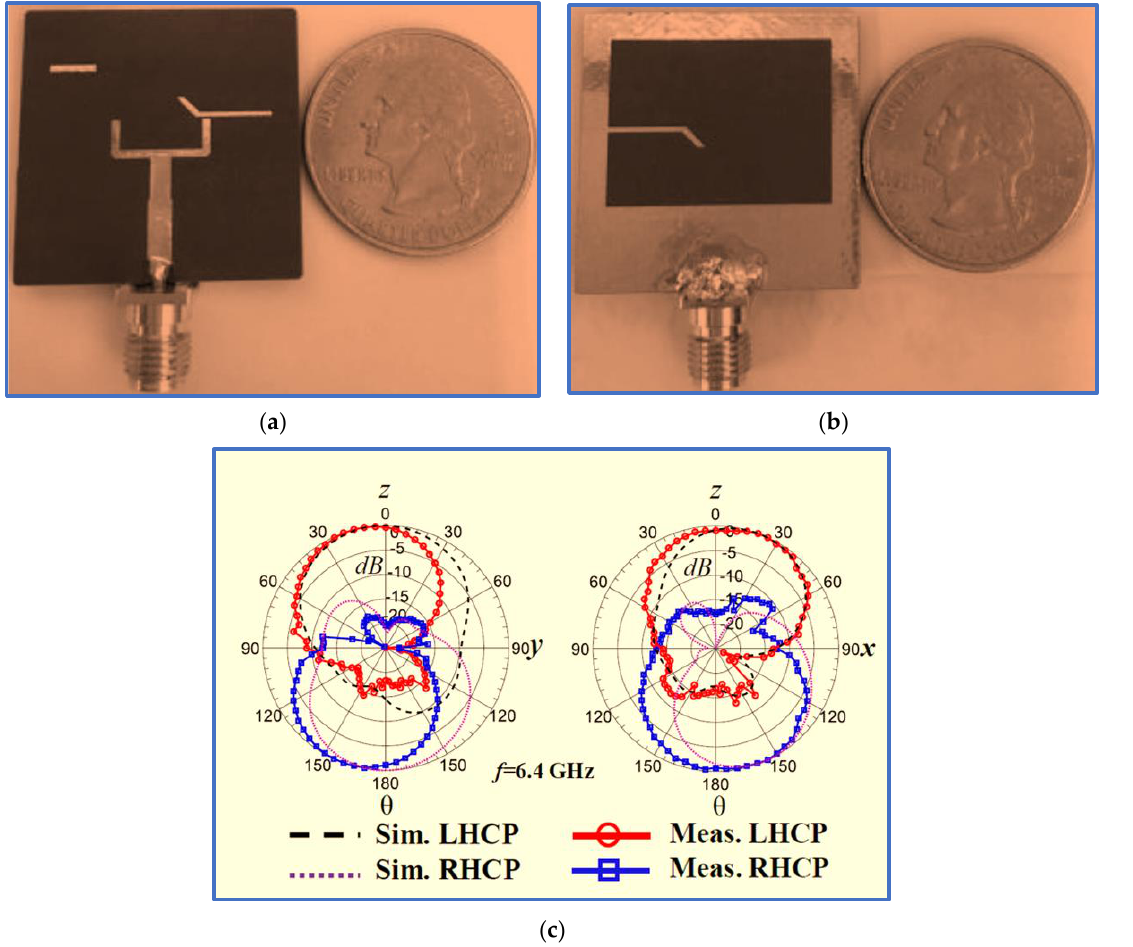
Figure 9. A square slot antenna: ( a ) front view; ( b ) back view; ( c ) simulated and measured radiation patterns [85].